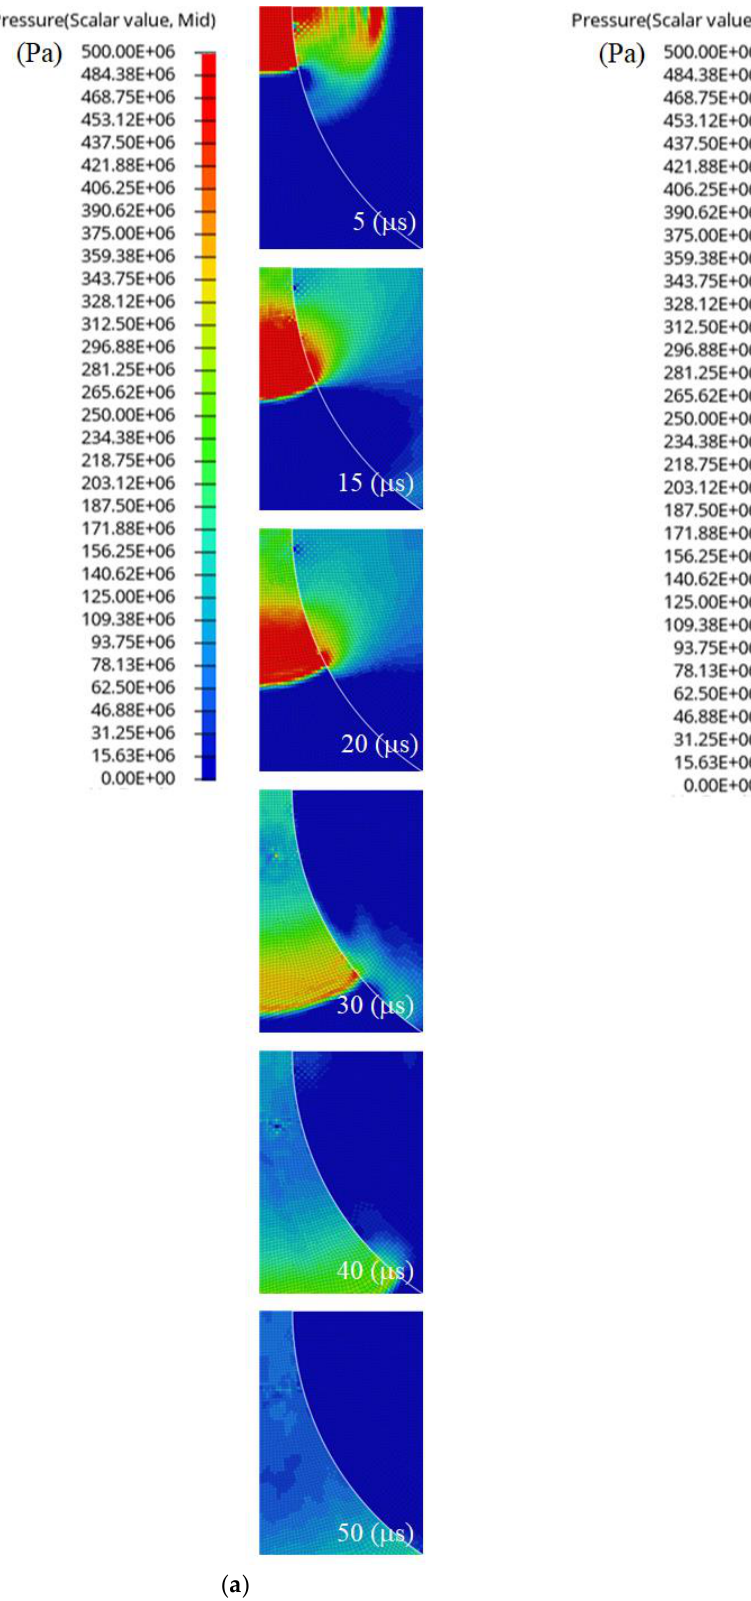
Figure 11. Pressure contour diagrams obtained by numerical simulation of the ( a ) hyperbolic pressure vessel and ( b ) parabolic pressure vessel.